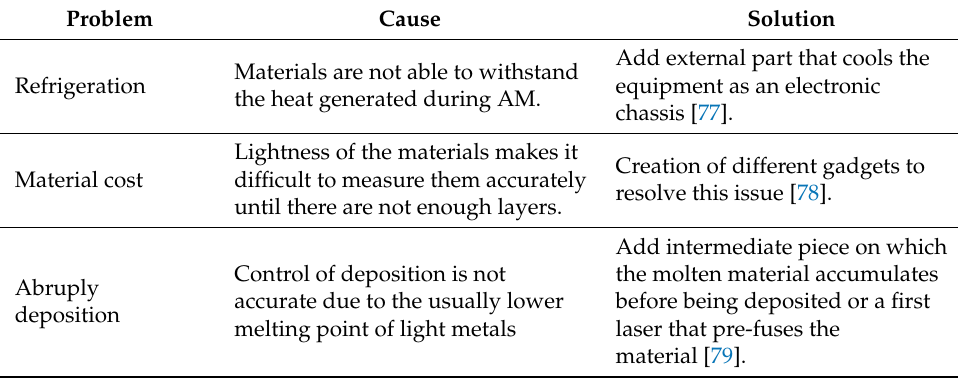
Table 3. Associated problems to MAM and their